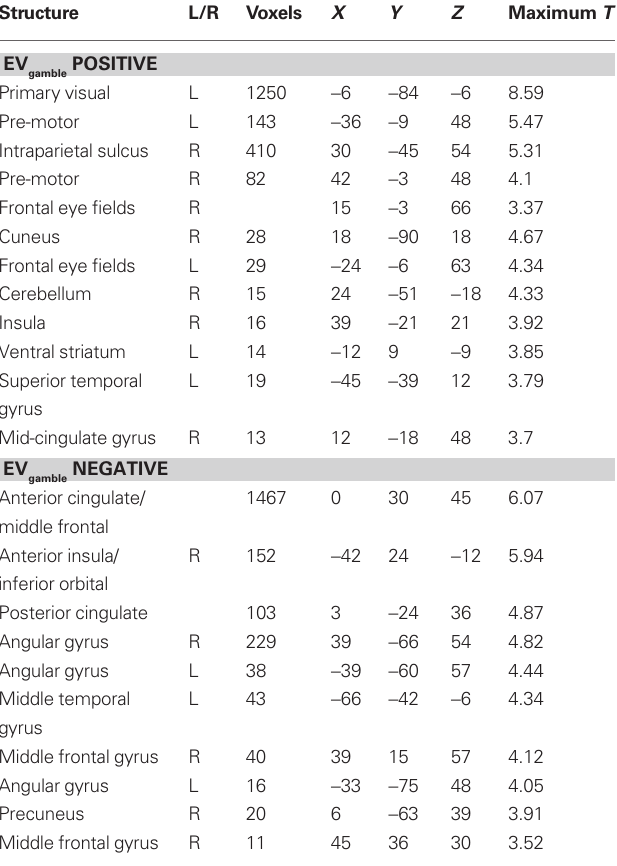
) during the lottery gamble